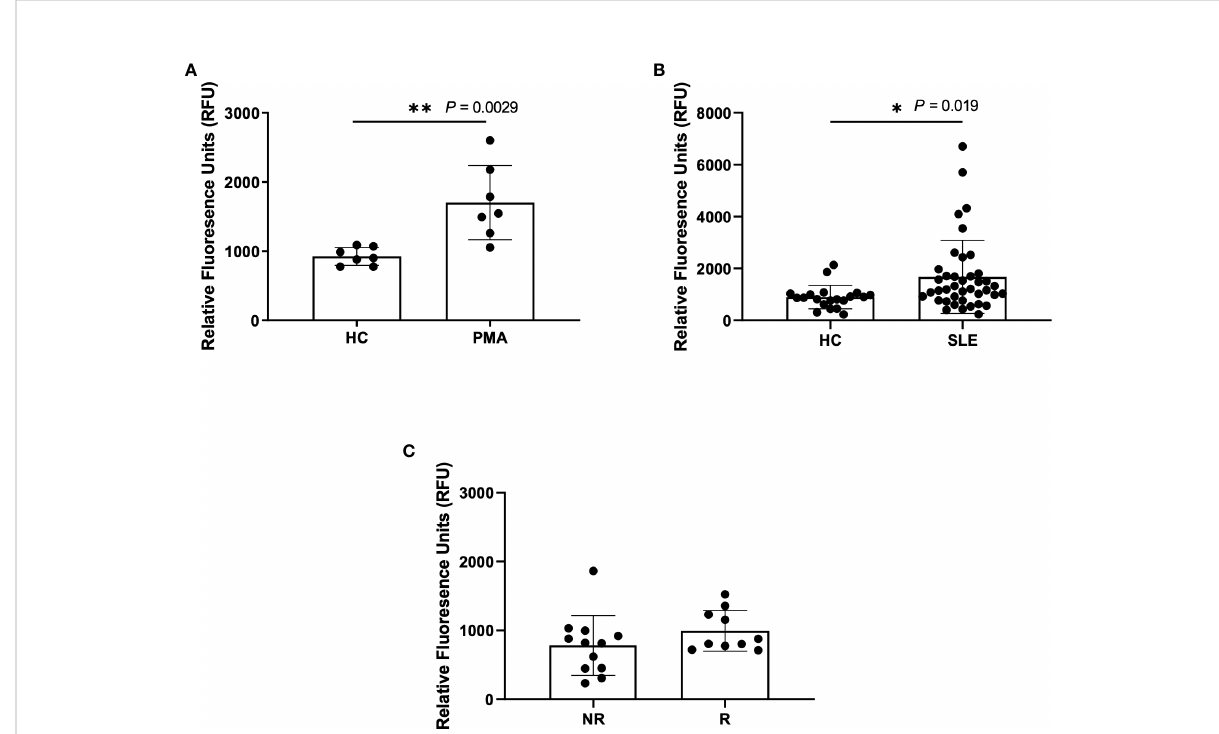
FIGURE 1 Higher NETs are detected in plasma from PMA treated samples and SLE samples using Sytox Green assay. Plasma samples were incubated with Sytox Green for 5 minutes and fl uorescence was measured using microplate reader. (A) Plasma samples from untreated healthy controls (HC) and PMA treated healthy donors (PMA, n=7), (B) SLE patients (n=40) and healthy controls (n=20), and (C) non-risk (NR, n=12) and risk (R, n=10) donors from the Genotype and Phenotype Registry. Single data points represent individual donors. Plotted data are after background subtraction. Data are presented as mean ± SD. P values are reported after unpaired parametric T test was performed *<0.05;